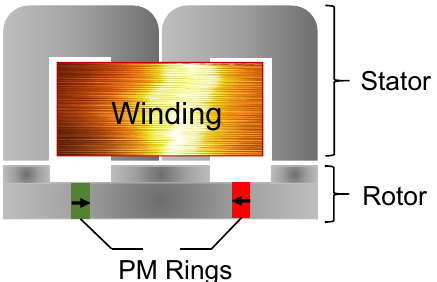
Figure 2. Axial view of the Hybrid Rotor 3D-Flux machine topology.